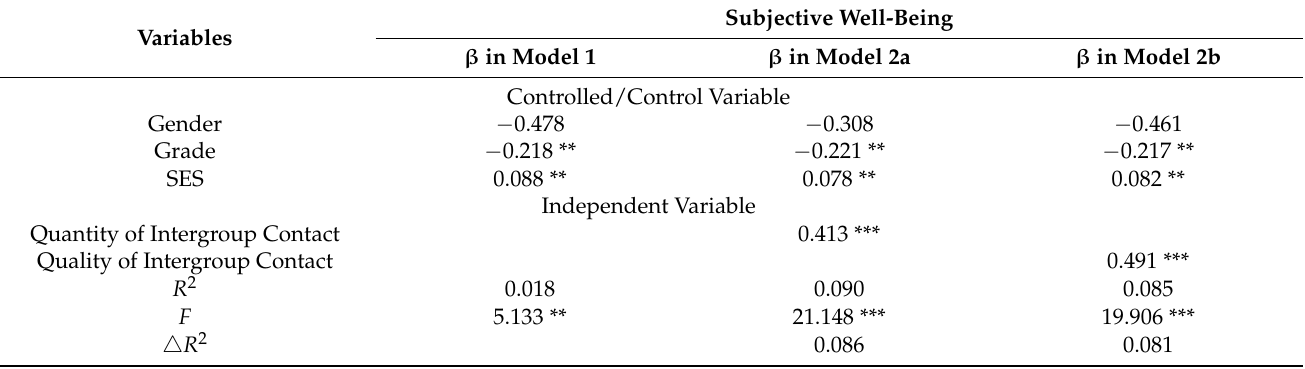
Table 2. Prediction of intergroup contact on subjective well-being of college students at Minzu universities ( N =